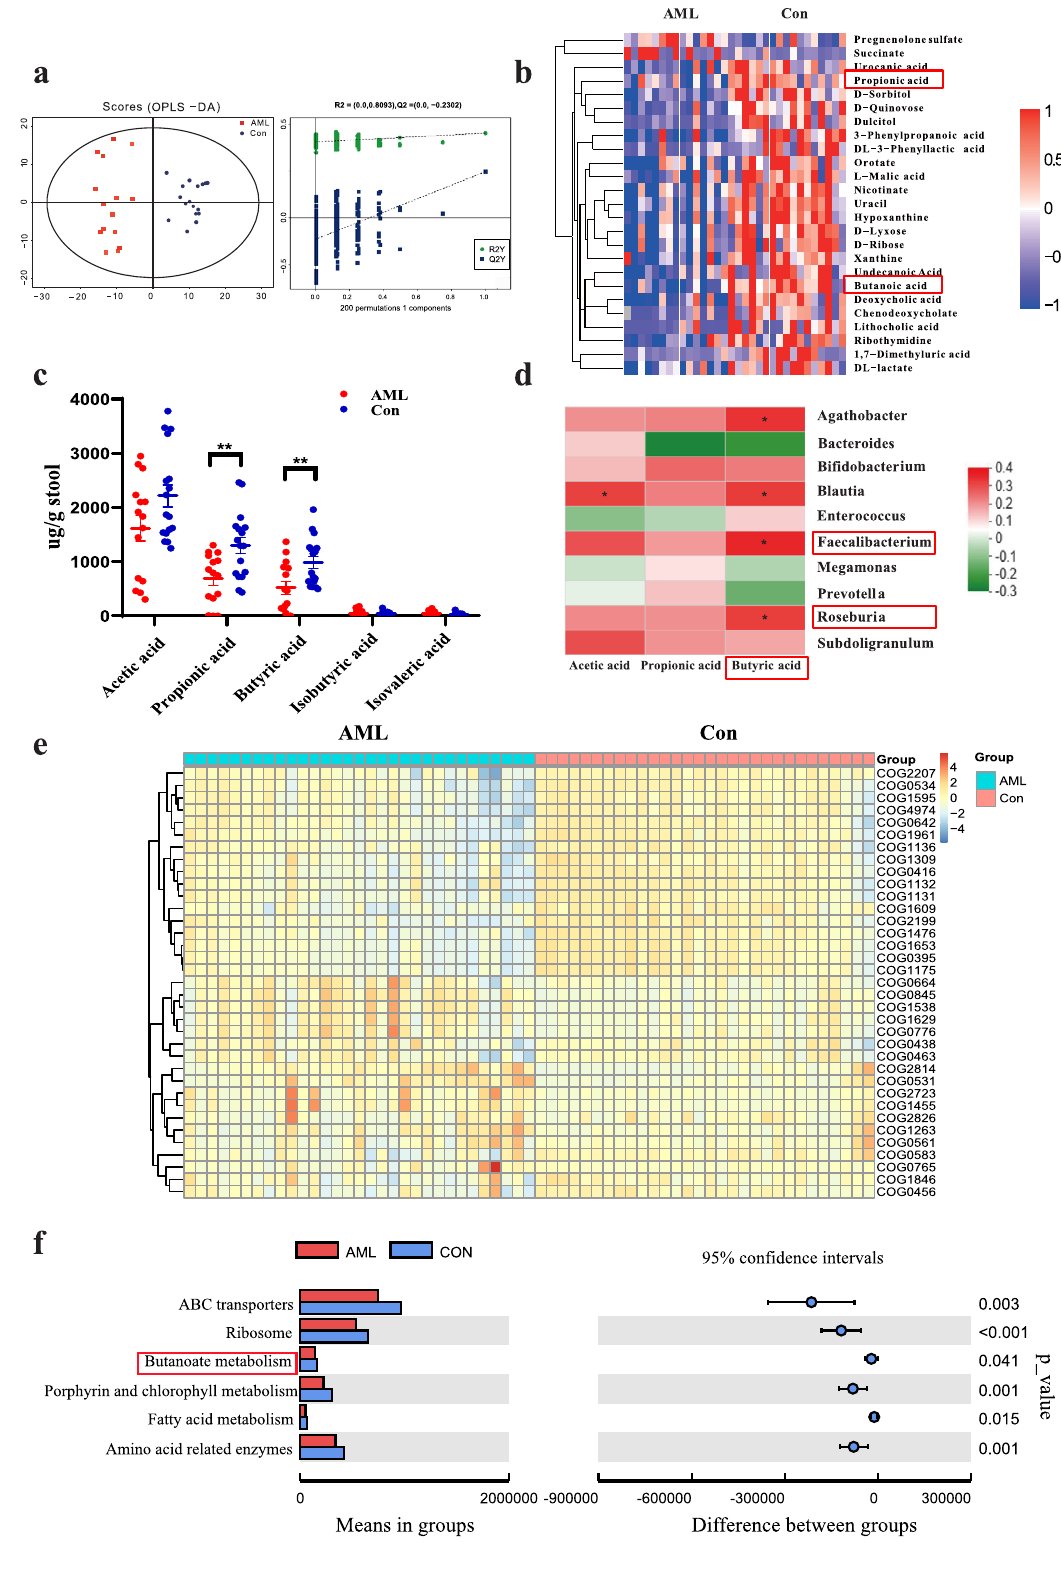
splenomegaly than the control AML mice, and the percentages of GFP + leukaemia cells in the peripheral blood, spleen, and BM were higher in LPS-treated than in control AML mice (Fig. 7h, i). Through microscopy, leukaemia cell in fi ltration into the spleen was observed to show an aggravated tendency in LPS-treated compared with control AML mice (Fig. 7j). Similarly,